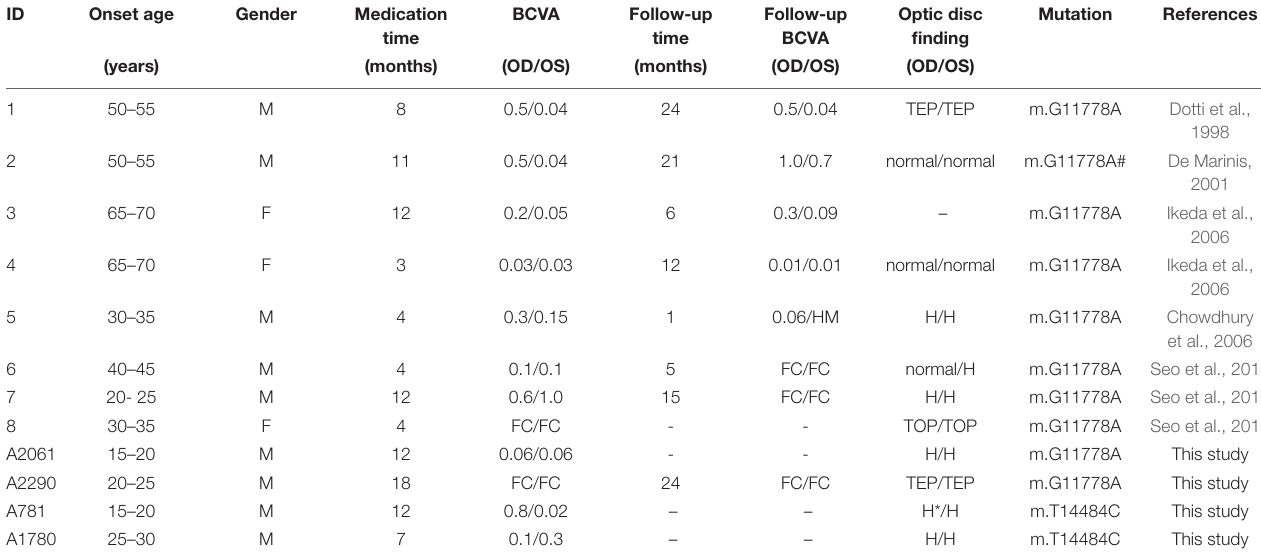
TABLE 4 | Clinical features of reported patients with EMB-induced